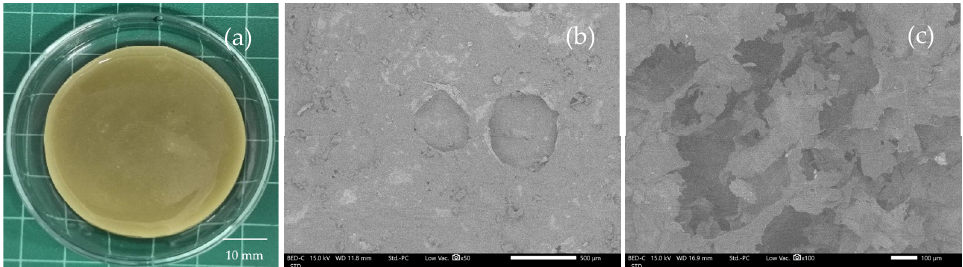
Figure 8. The visual appearance ( a ) and SEM micrograph of the surface and cross-section of Figure 8 . Visual appearance (a) and SEM micrograph of surface and cross ‐ section of C 2.5 A 0.5 P 0.5 ‐ Q at C 2.5 A 0.5 P 0.5 -Q at 50× and 100× magnifications ( b , c ). C 2.5 A 0.5 P 0.5 -Q at 50 × and 100 × magnifications ( b , c ). 50× and 100× magnifications (b and c)